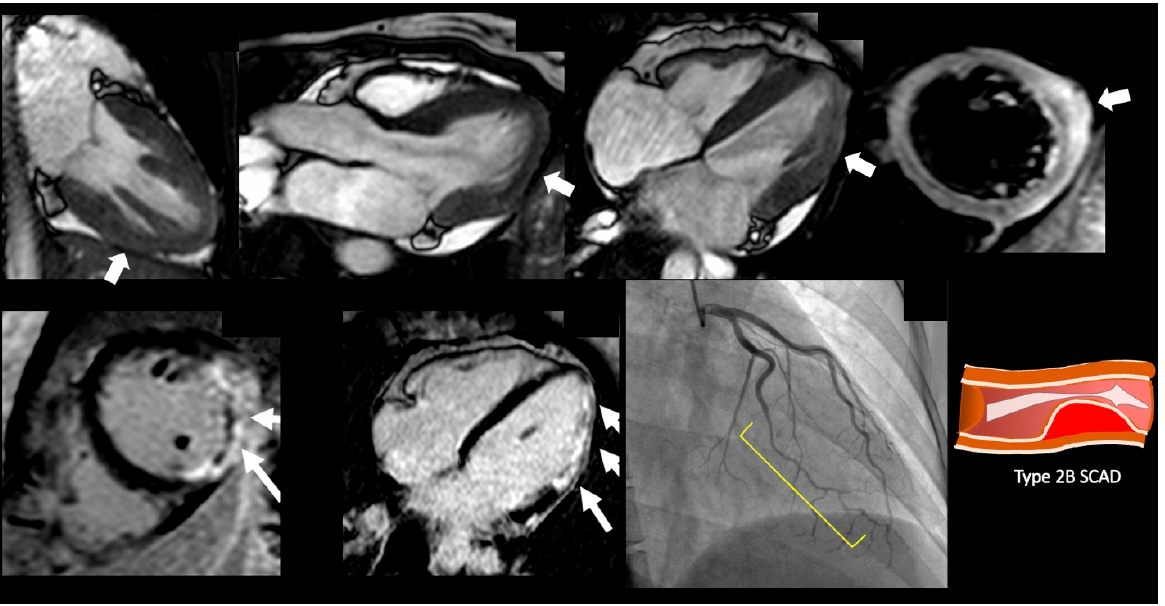
Figure 2. Demonstrative case of a spontaneous coronary artery dissection. A 47-year-old female presenting with chest pain, with nonobstructive coronary artery disease. On SSFP cine imaging showed borderline cardiac function with EF 50% with myocardial edema of the inferolateral wall and corresponding transmural late gadolinium enhancement in inferolateral wall with microvascular obstruction. On cardiac catheterization she was found to have type 2B SCAD lesion of the left circumflex artery.